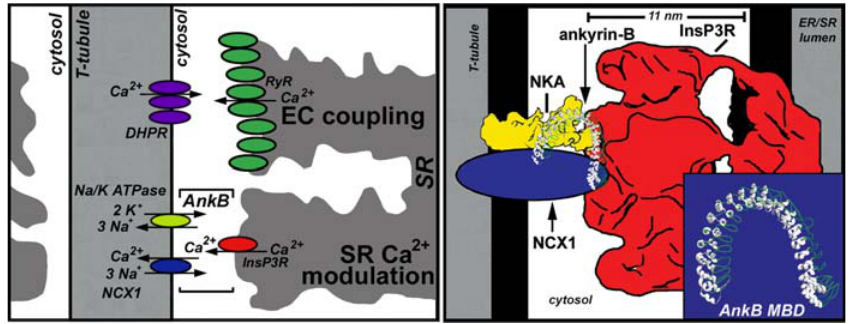
Figure 8. Model of the Cardiac Ankyrin-B Complex (Left) Model of ankyrin-B-dependent complex of NKA, NCX1, and InsP 3 R at T-tubule/SR sites distinct from the classic ‘‘ dyad. ’’ (Right) Scale model of ankyrin-B complex based on approximate dimensions of represented proteins. The protein ratios are not representative for in vivo couplings as there are likely 50–100 RyR 2 for each InsP 3 R in a ventricular cardiomyocyte [32]. DOI: